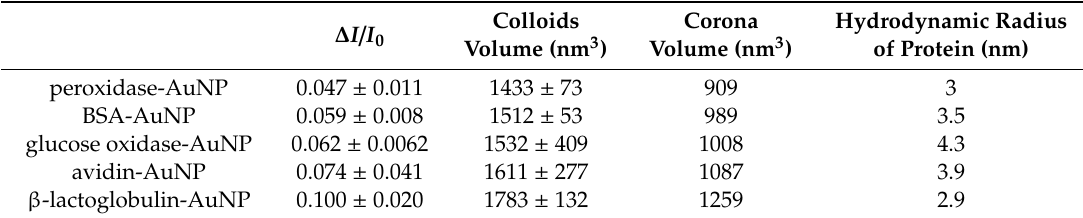
Table 1. Results obtained from the relative current blockade. The error is the full width at half maximum (the corona volume is calculated from colloid volume—AuNP